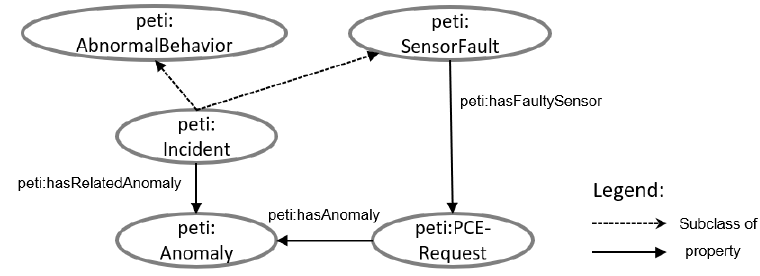
Figure 9. Incident